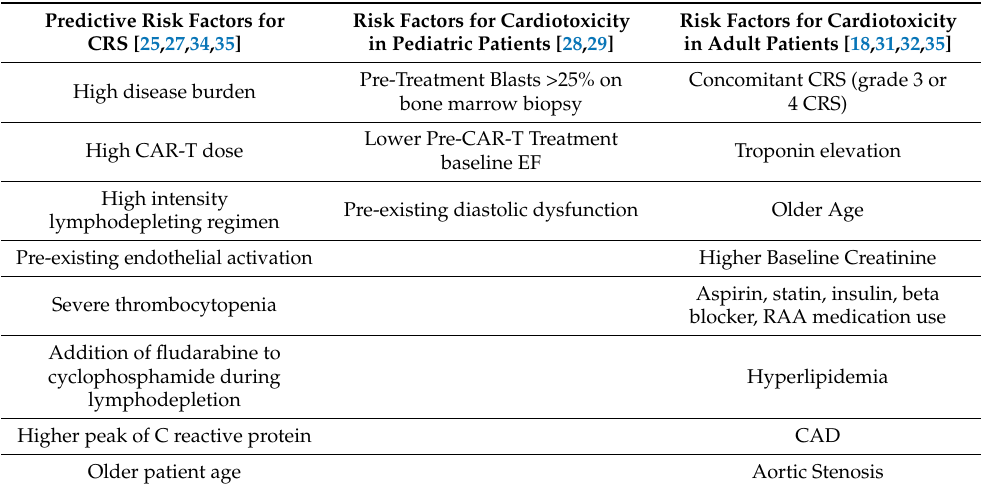
Table 7. Baseline factors that may increase the risk of